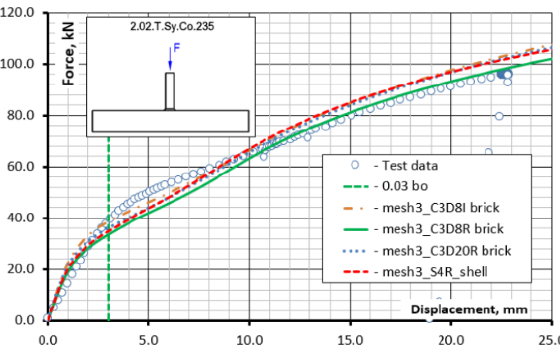
Figure 6. Validation of FE models against labora- tory tests for a standard joint.